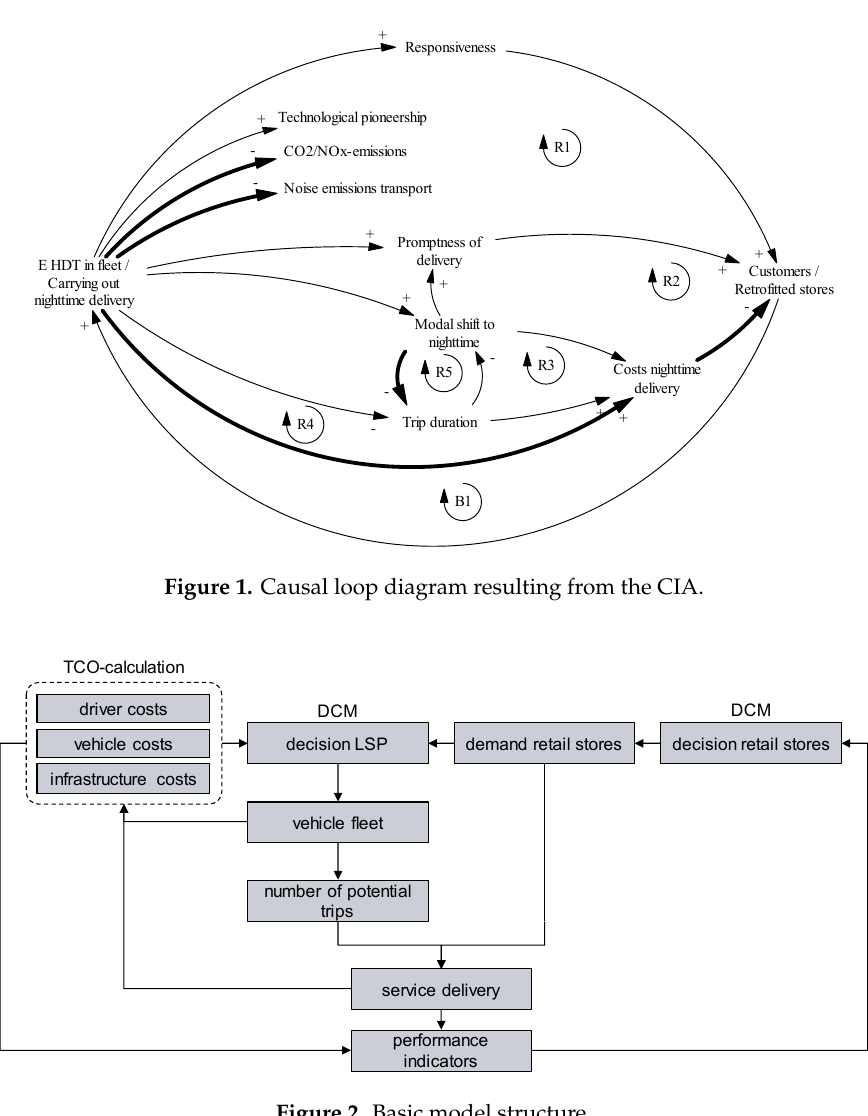
Figure 2. Basic model structure.